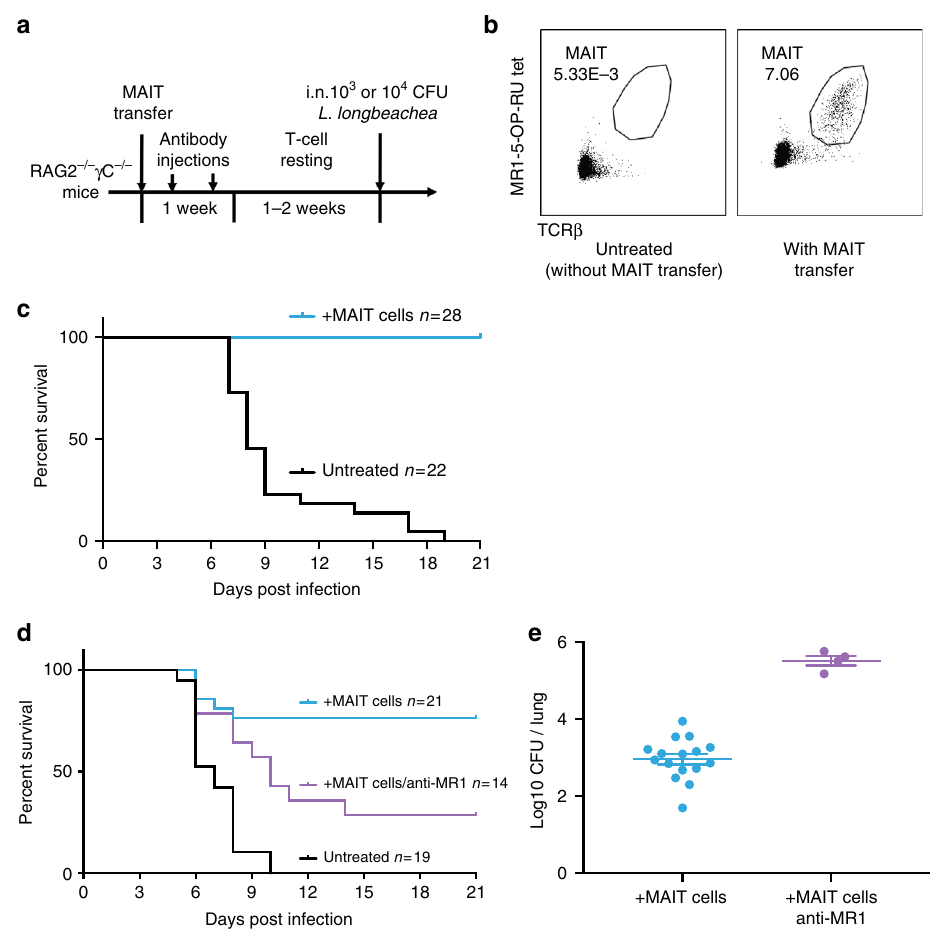
Fig. 6 Adoptive MAIT cell transfer rescues Rag2 − / − γ C − / − mice from fatal Legionella infection. a Schematic of protocol: 10 5 pulmonary MAIT cells from C57BL/6 mice previously infected with 10 6 CFU S . Typhimurium BRD509 for 7 days to expand the MAIT cell population were sorted and transferred intravenously into Rag2 − / − γ C − / − mice, followed by intraperitoneal anti-CD4 and anti-CD8 antibody injection (0.1 mg each) twice within 1 week to deplete contaminating conventional T cells. After 2 weeks, mice were infected with 10 3 ( c ) or 10 4 CFU ( d ) i.n. of L. longbeachae . b Representative plots showing live (7AAD − ) hematopoietic (CD45.2 + ) cells with percentages of MAIT cells in the lungs of Rag2 − / − γ C − / − mice which were untreated or were recipients of adoptively transferred MAIT cells. c Survival of Legionella -infected untreated or MAIT cell-recipient Rag2 − / − γ C − / − mice after 10 3 CFU i.n. L. longbeachae infection. d Survival of Legionella -infected untreated or MAIT cell-recipient Rag2 − / − γ C − / − mice after 10 4 CFU i.n. L. longbeachae , with or without